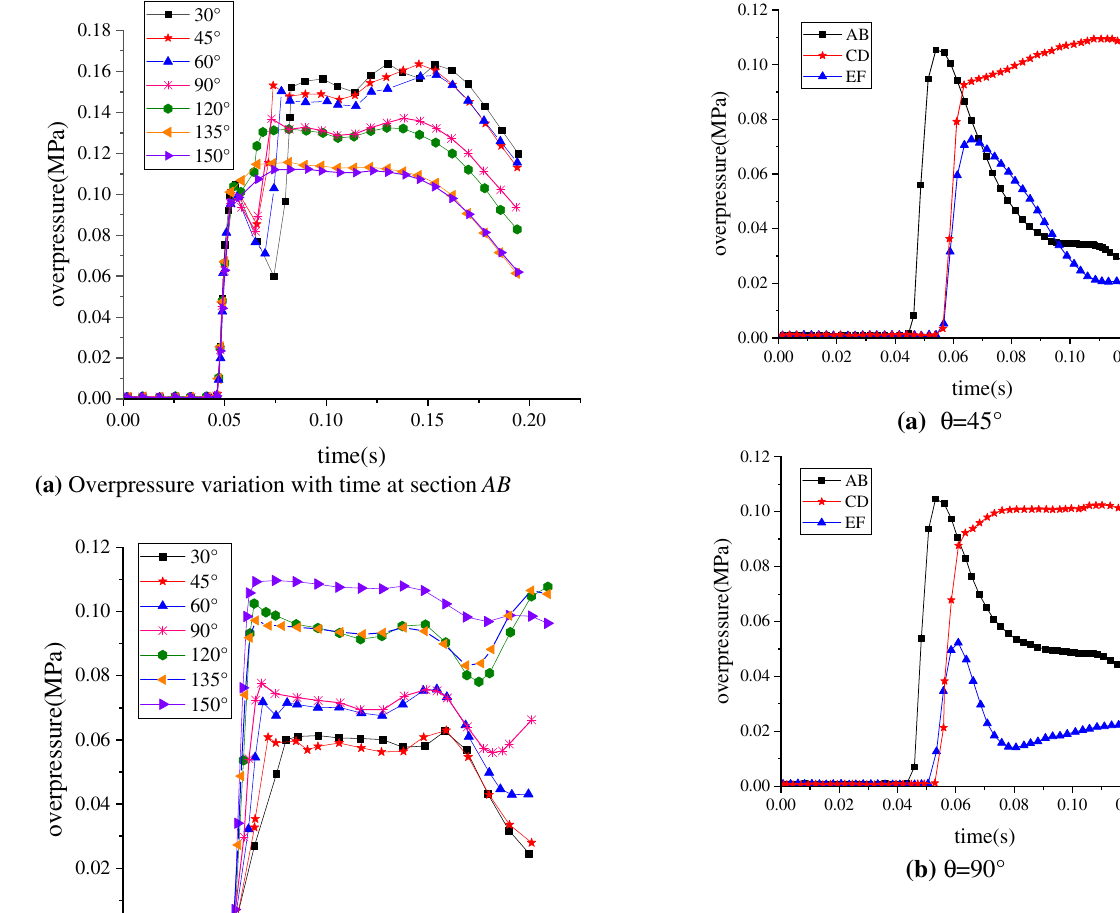
Fig. 9 Gas overpressure variation with time for different bifurcation